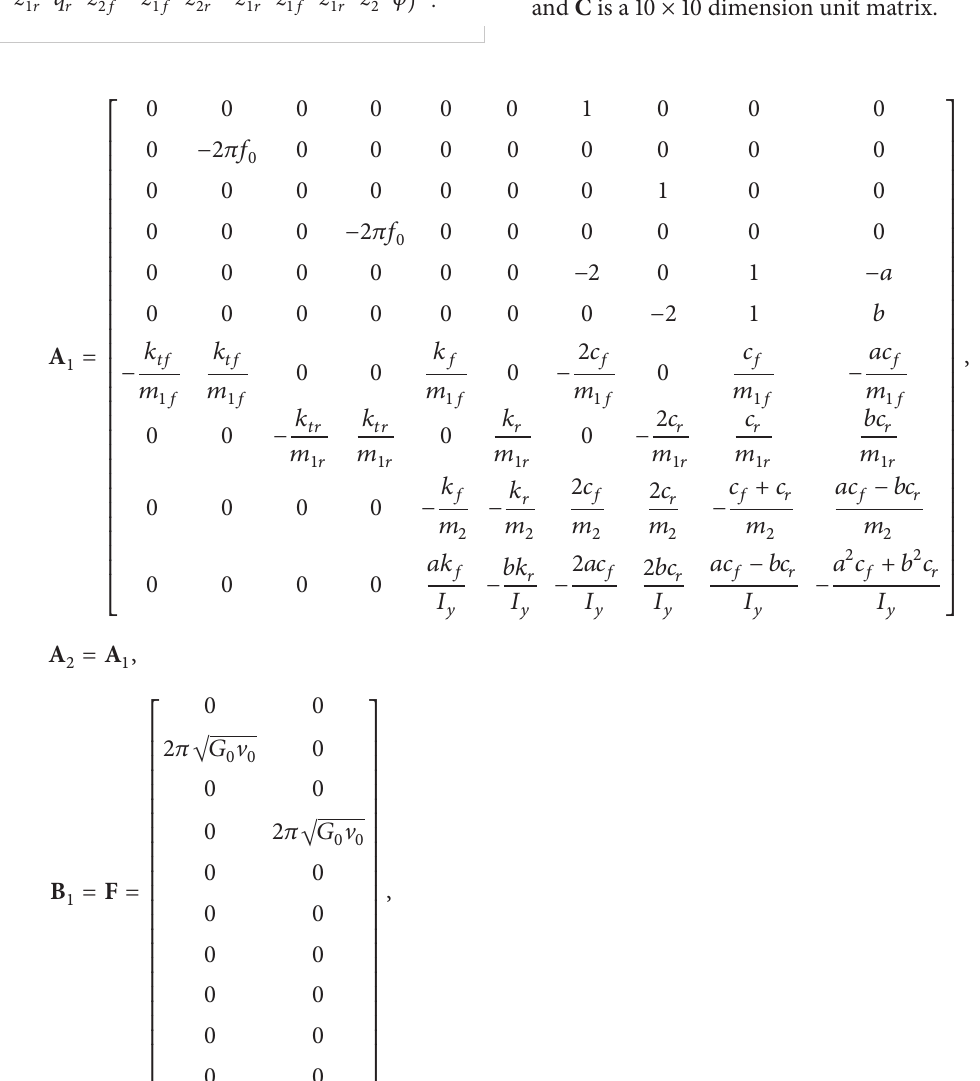
𝑇 , U is the input 𝑇 ,